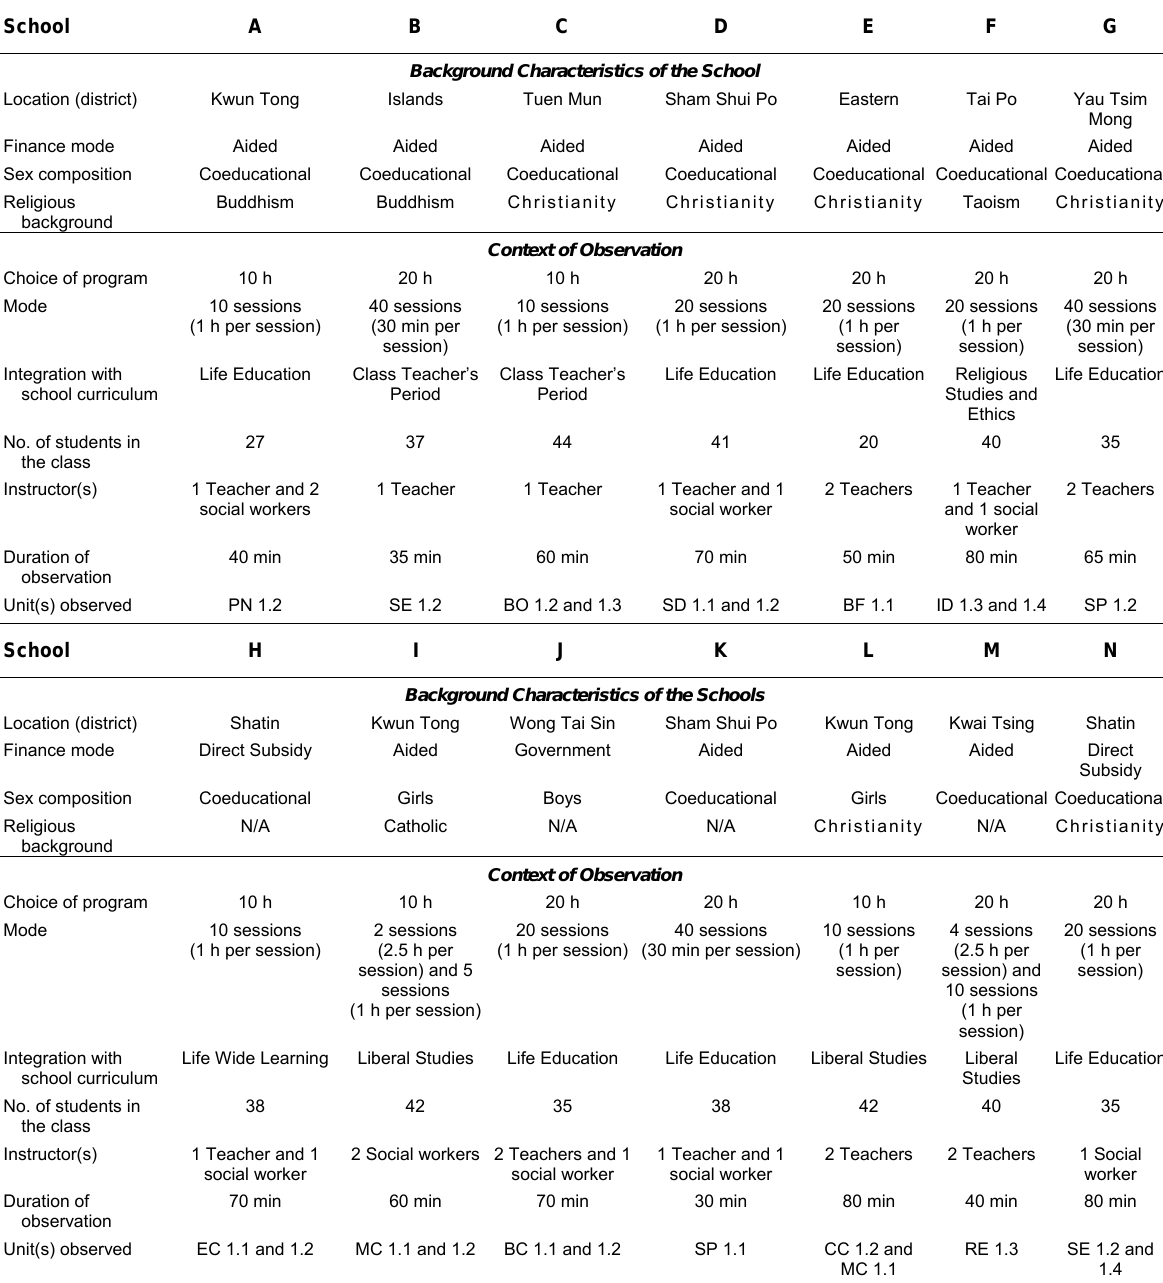
Summary on the Characteristics of the